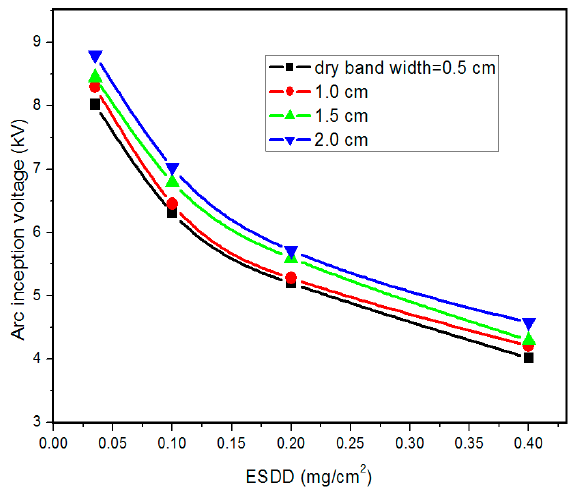
Figure 10. Arc inception voltage at different dry band widths, where NSDD = 0.75 mg/cm 2 , humidity level = low, temperature = 10 °C, and standard deviation = 3.3%–4.6%.